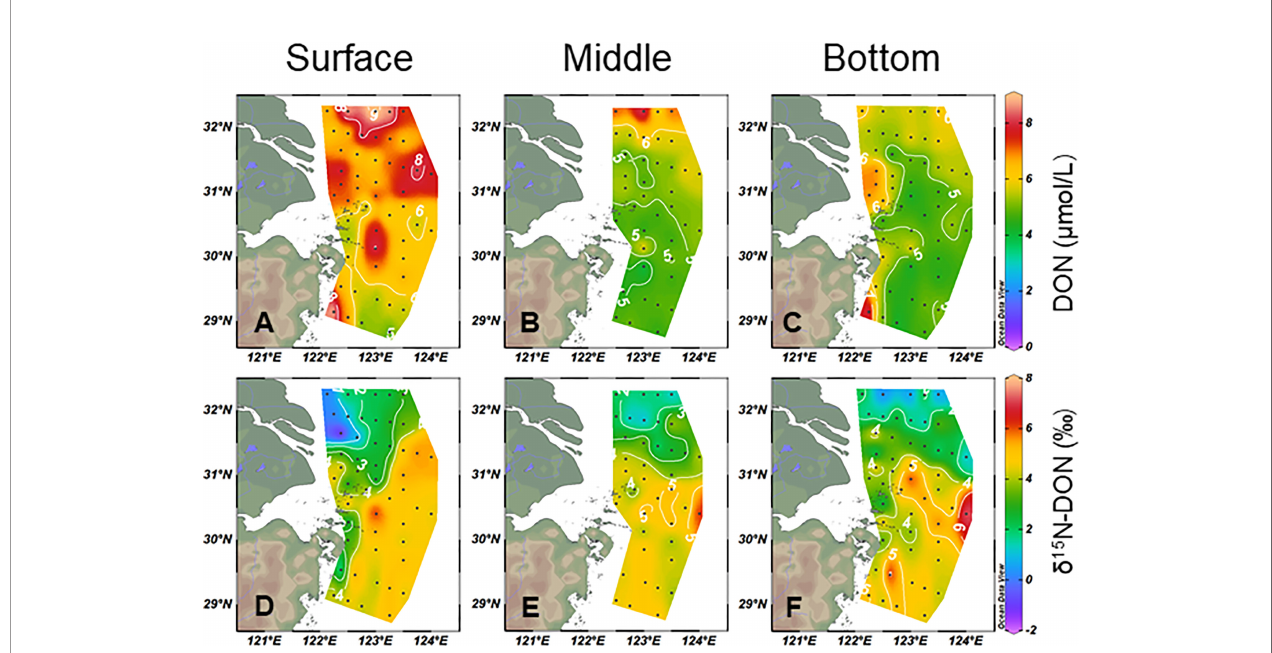
comes mainly from TWC and CDW in the nearshore area. The bottom water in the study region is a mixture of TWC, KBBCNT, and YSMW. KBBCNT contributes the most. YSMW is con fi ned to the northern part of the study area.